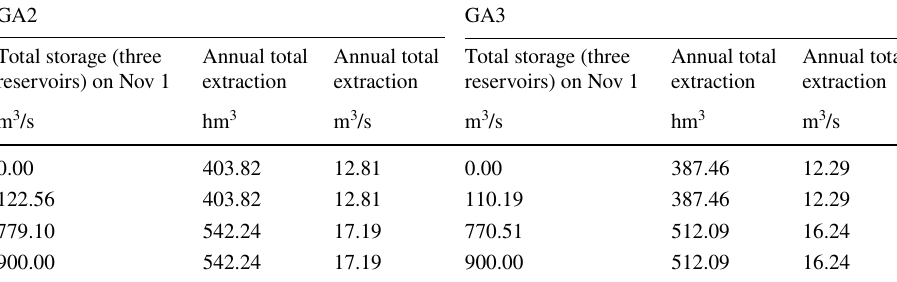
Table 8 Values based on the Z curve of genetic algorithm GA3 versus GA2 policy, with extractions in hm 3 and m 3 /s